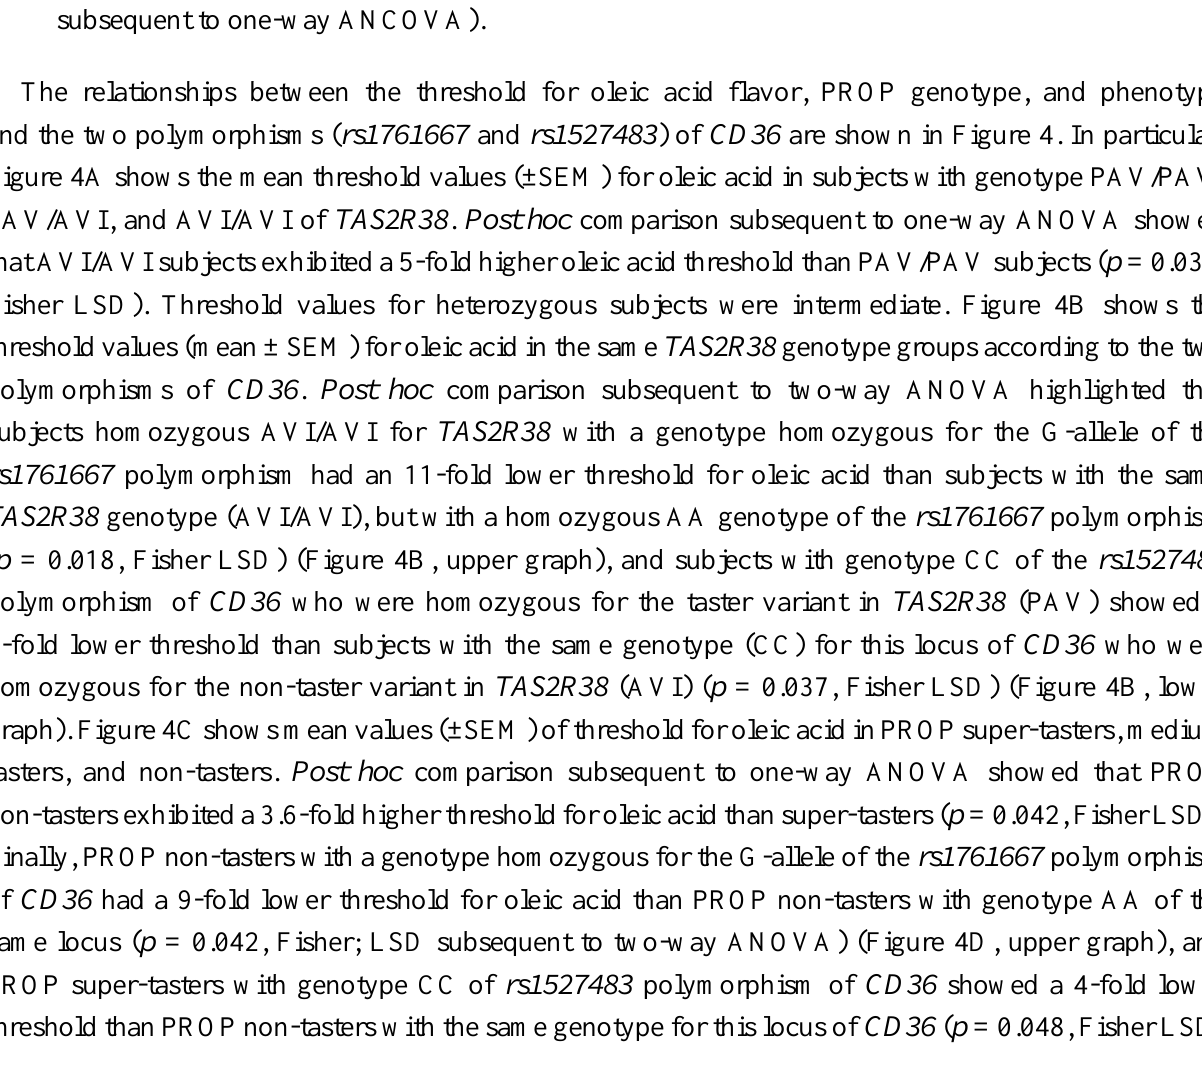
Figure 3. Mean values (±SEM) of the flavor threshold for oleic acid in individuals with genotype GG, GA, and AA of rs1761667 locus and genotype CC, CT, and TT of rs1527483 locus of CD36 . Different letters indicate a significant difference ( p < 0.033, Fisher LSD test subsequent to one-way